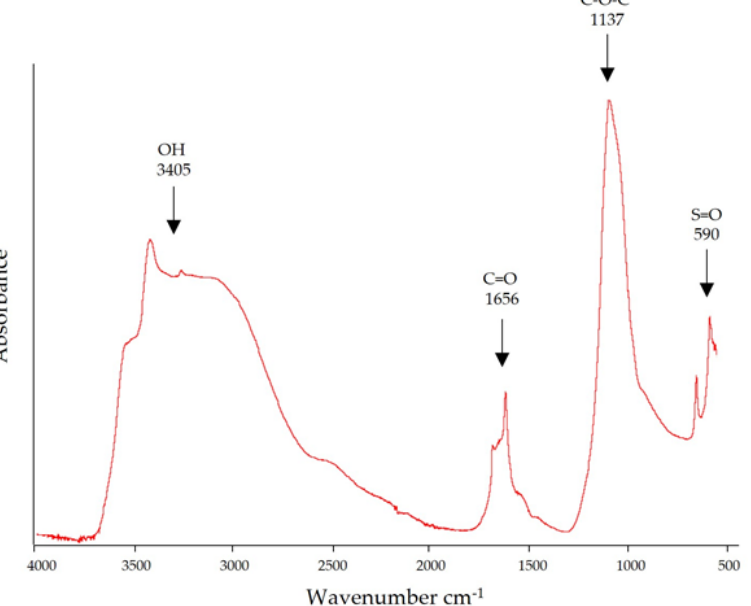
Figure 2. Attenuated Total Reflectance-Fourier Transform Infrared (ATR − TIR) spectrum of the CMSP from C. muelleri . The arrows indicate the main absorption bands.